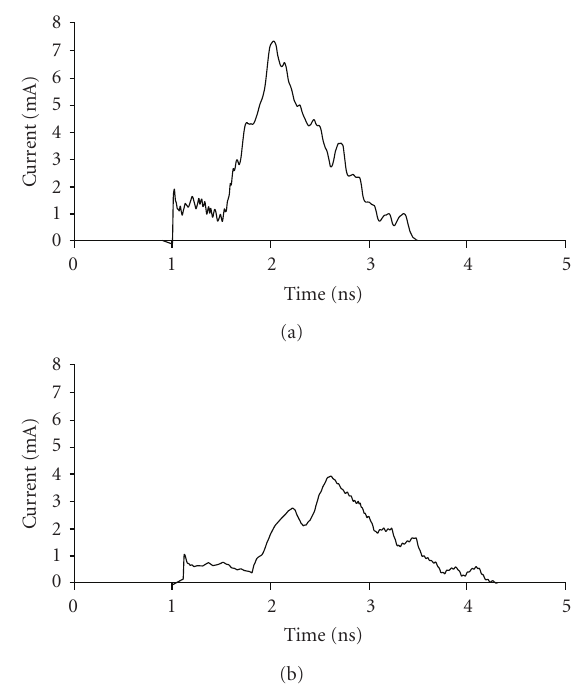
The profile at 1.8 V is lower (average is 1.5mA) and longer (by about 700